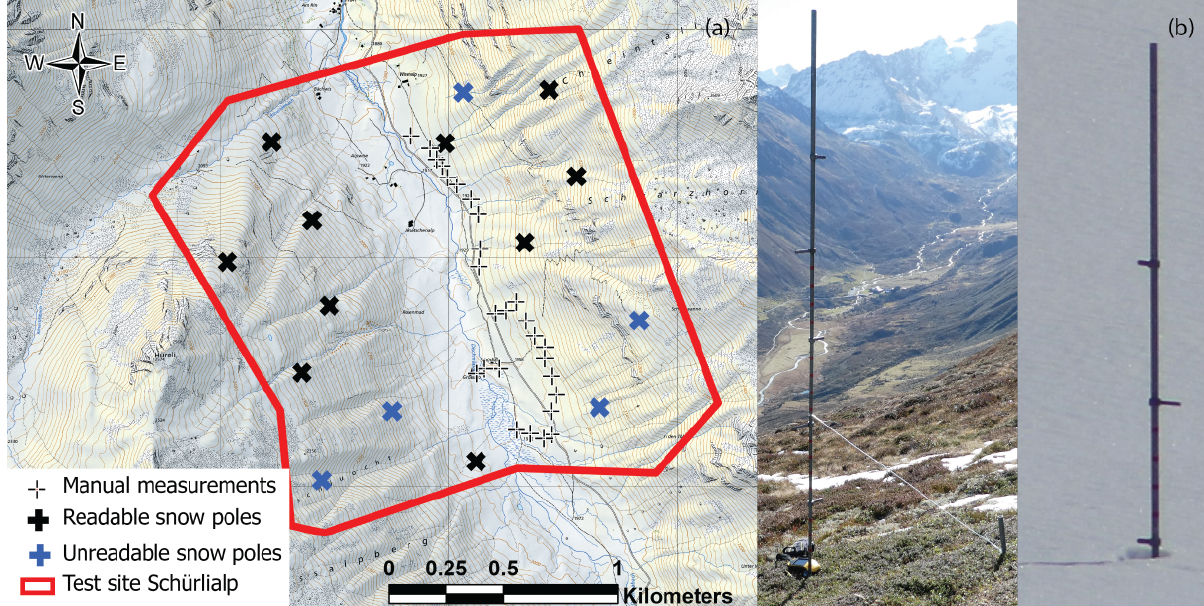
Figure 2. Panel (a) shows the distribution of the snow poles and the manual snow measurements at the Schürlialp test site. The snow poles are separated into the readable (black crosses) and unreadable ones (blue crosses). The thin black crosses show the locations of the manual measurements. The two images in (b) show a snow pole in summer and winter. The snow poles have a hinge at the foot and are tensioned back with a nylon cord. This way they simply fold down in the event of an avalanche and are not dragged along (Swiss Map Raster, source: Federal Office of